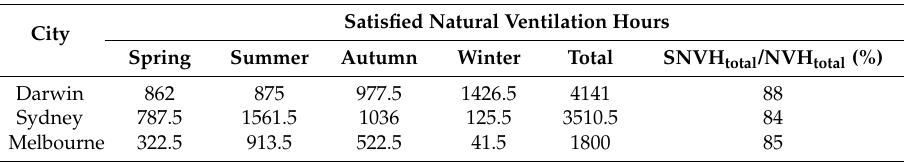
Table 3. Thermal comfort potential during different